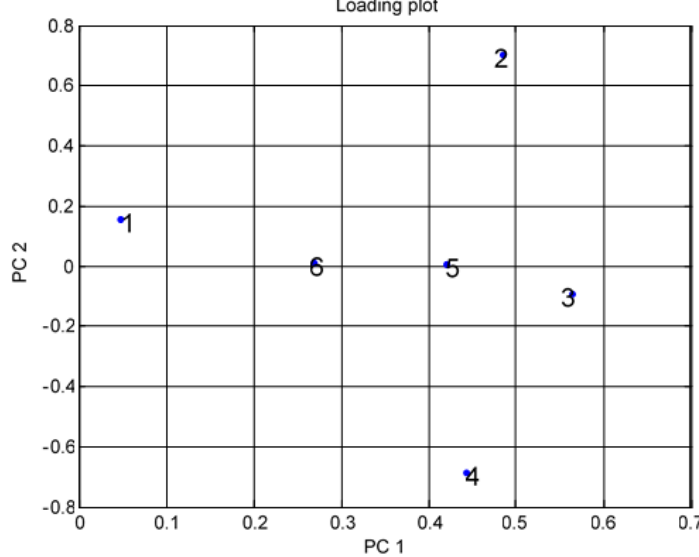
Figure 4. Multivariate technique on organic gases for different feature loading designs.